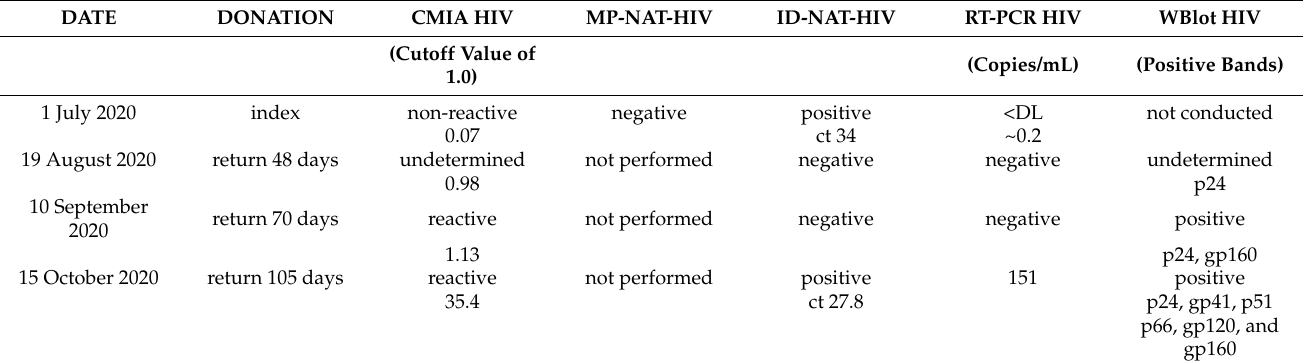
Figure 2. ( A ) The minipooled NAT (MP-NAT-HIV) of 6 samples including from the donor who reported the use of HIV prophylaxis showing an altered curve profile below the cutoff for a positive reaction. ( B ) ID-NAT-HIV from the same donor showing amplification at a high cycle threshold (Ct) value of 34. The HIV reaction curve is shown in green. The calibration reaction curve is shown in red. Table 2. HIV serologic and molecular test results over time of donation candidate who reported use of HIV pre-exposure prophylaxis.